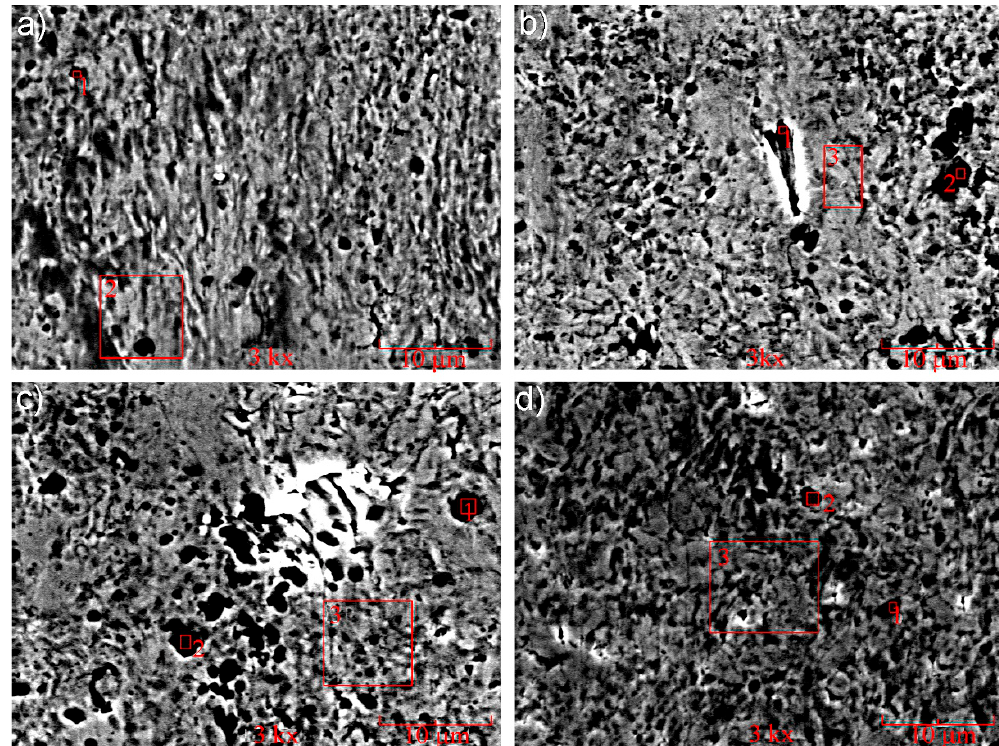
Figure 16. Worn surfaces of samples of MMCs tested: ( a ) 1 wt% of Al 2 O 3 additive, ( b ) 1 wt% of SiC additive, ( c ) 0.33 wt% C + 0.33 wt% Al 2 O 3 + 0.33 wt% SiC additives, ( d ) one of the compositions providing minimal wear rate (see Figure 15). Table 5. The SEM analysis results of the FeGr1 + 1 wt% alumina worn surface (Figure 16a, areas 1 and 2).